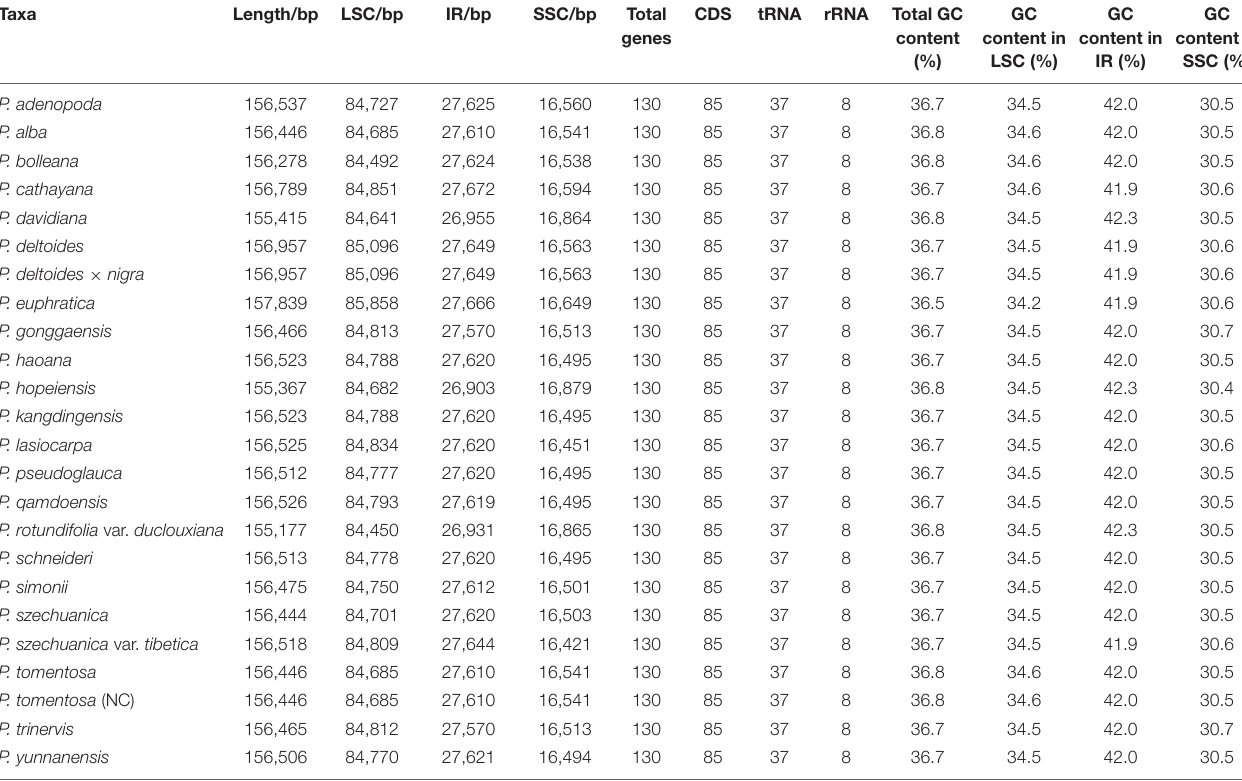
TABLE 4 | Summary of complete chloroplast genomes for 24 Populus